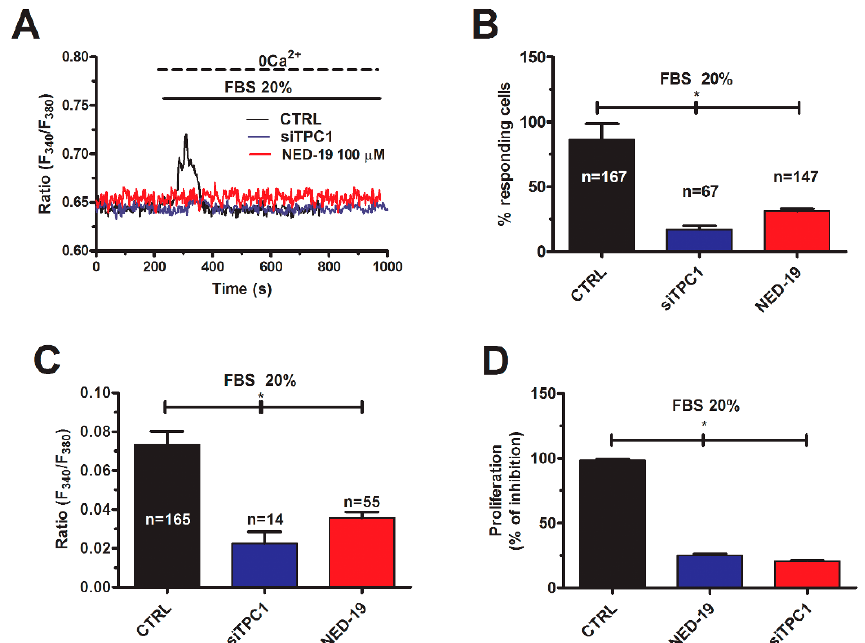
Figure 8. TPC1 mediates FBS-induced lysosomal Ca 2+ release and proliferation in mCRC cells. ( A ) 20% FBS induced an intracellular Ca 2+ transient that was significantly reduced by NED-19 (100 µM, 30 min) and by deleting TPC1 with the specific siTPC1. ( B ) mean ± SE of the percentage of responding cells under the designated treatments. The asterisk indicates p < 0.05. ( C ) mean ± SE of the amplitude of the peak Ca 2+ response to NAADP under the designated treatments. The asterisk indicates p < 0.05. ( D ) mean ± SE of the percentage of 20% FBS-induced cell proliferation under control conditions and upon pharmacological (NED-19) and genetic (siTPC1) blockade of NAADP-induced Ca 2+ release. The asterisk indicates p < 0.05.